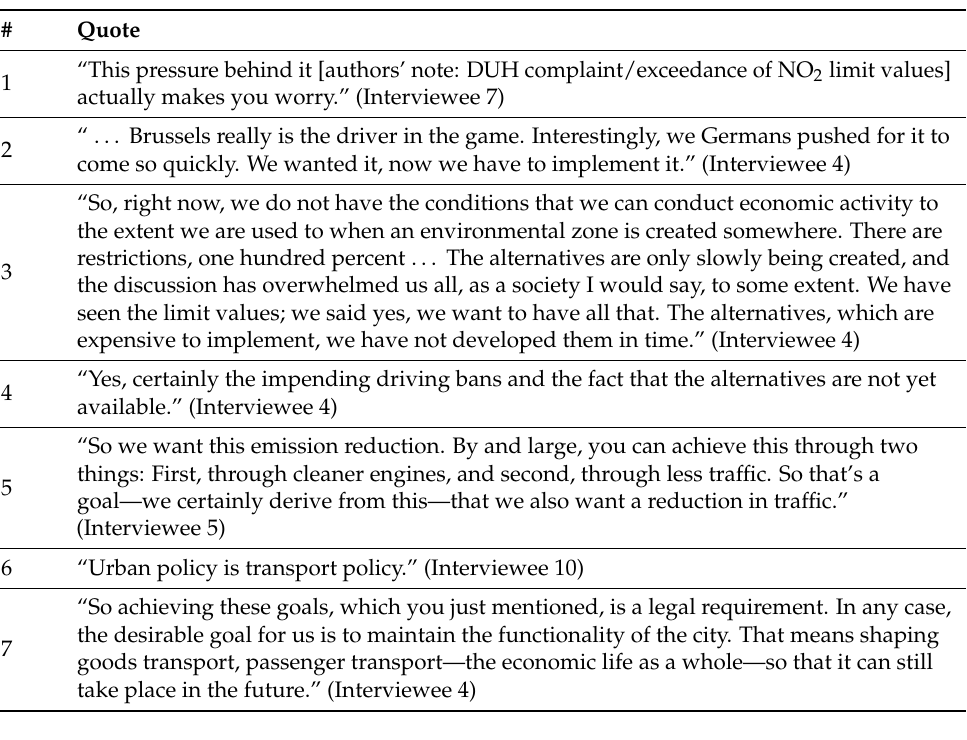
Table 4. Quotes from the interviews outlining the problem stream in the three Lead